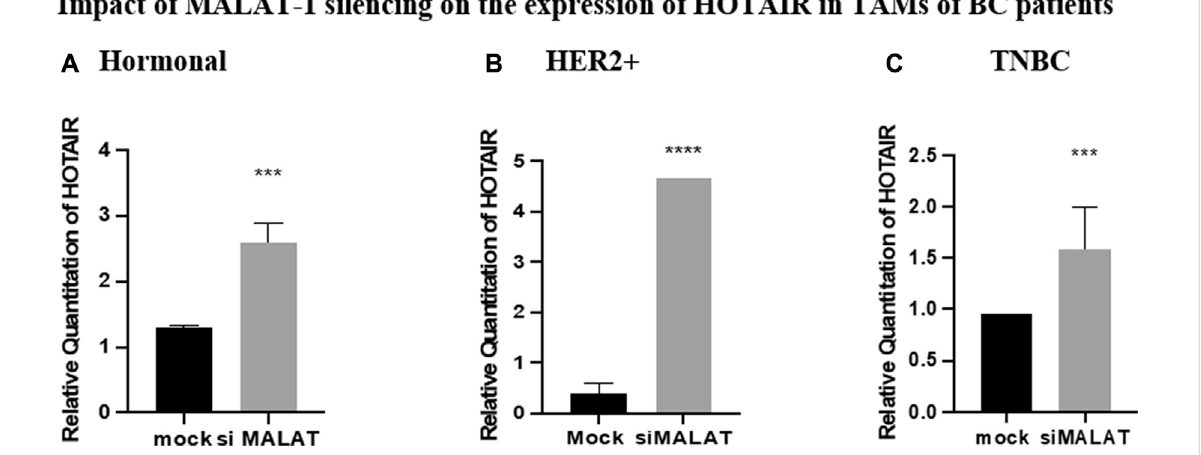
FIGURE 5 Impact of MALAT1 silencing on the expression of HOTAIR in TAMs of (A) hormonal, (B) HER2+, and (C) TNBC. HOTAIR mRNA levels were measured using qRT-PCR and were normalized to β -actin (endogenous control). The results showed that MALAT1 silencing resulted in statistically signi fi cant upregulation in HOTAIR in TAMs of the three subtypes when compared to the untransfected controls (mocks). Parametric student t -test was used for comparing two groups **** = p < 0.0001, *** = p < 0.001, ** = p < 0.01, * = p < 0.05, and ns = statistically not signi fi cant.